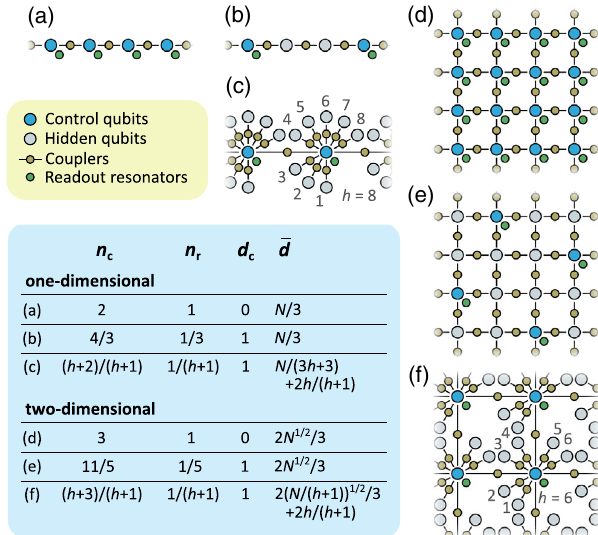
FIG. 1. Illustration of a few different one-dimensional (a) – (c) and two-dimensional (d) – (f) qubit network configurations. Panels (a) and (d) represent the standard setting with direct control and readout of each qubit. Panels (b) and (e) are similar configura- tions but with a fraction of the qubits hidden. This fraction is chosen such that each hidden qubit is adjacent to a control qubit. Panels (c) and (f) are settings where each control qubit has a number h of hidden qubits attached to it in a star geometry. The number of control lines per qubit n , the number of readout c resonators per qubit n , the maximal distance to a control qubit r ¯ d d between two randomly chosen , and the average distance c qubits as a function of the total number of qubits N are listed for comparison of the different